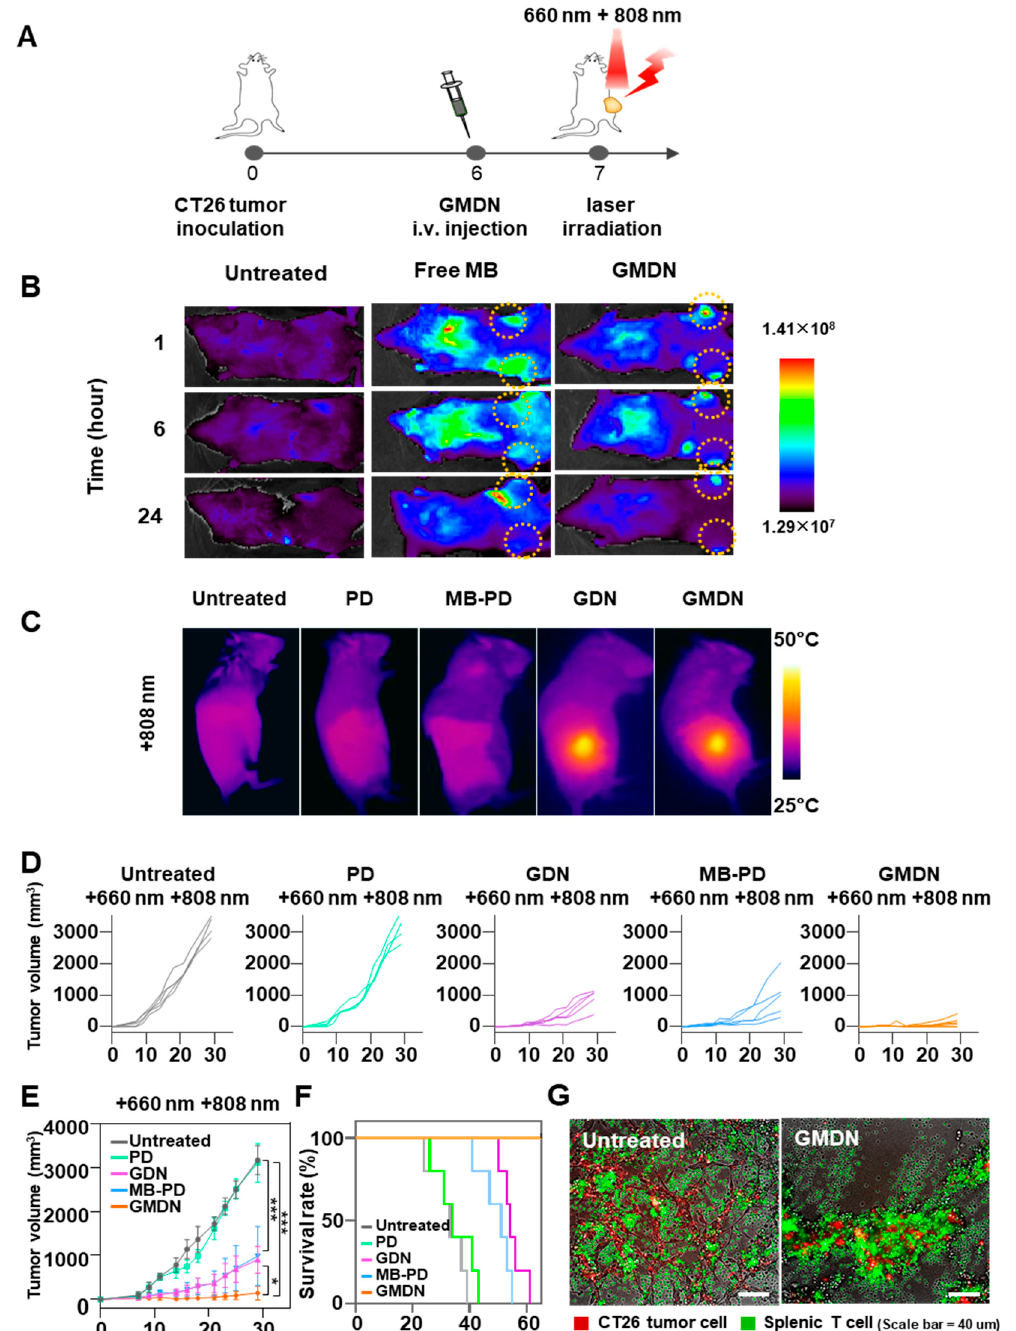
Figure 5. In vivo synergistic dual phototherapy of GMDN. The in vivo anti-tumor efficacy of GMDN was evaluated in CT26 tumor-bearing mice after light irradiation. ( A ) After CT26 tumor inoculation, GMDN were intravenously injected, followed by dual irradiation. ( B ) In vivo biodistribution of GMDN was evaluated by detecting fluorescence intensity from MB. ( C ) In vivo photothermal effect was confirmed by temperature measurement at the tumor site upon NIR irradiation. ( D , E ) In vivo anti-tumor efficacy was evaluated by tumor volume measurement up to 30 days after first tumor inoculation. ( F ) Survival was monitored for 65 days. ( G ) Anti-tumor efficacy was evaluated in a tumor cell co-culture model involving splenic T cells from treated or untreated mice (* p < 0.05; *** p < 0.001).